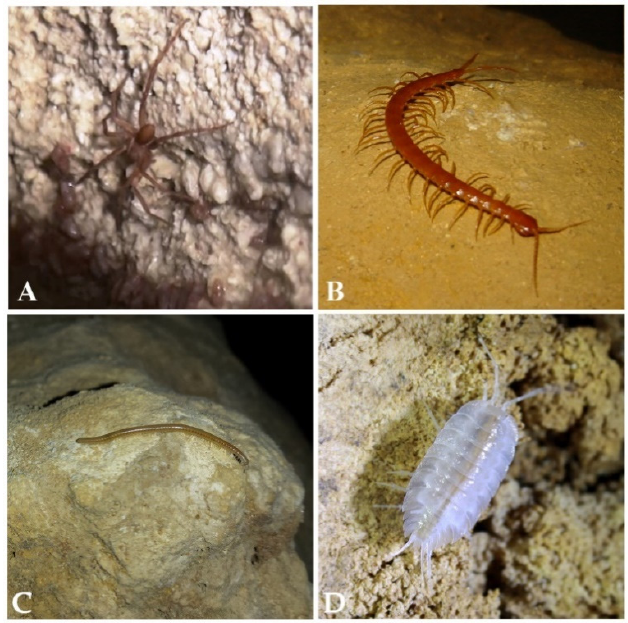
Figure 4. Terrestrial invertebrates present in Movile Cave; ( A ). the spider (Agraecina cristiani); ( B ). top predator chilopod (Cryptops speleorex); ( C ). millipede (Archiboreoiulus serbansarbui); ( D ). isopod (Trachelipus troglobius).